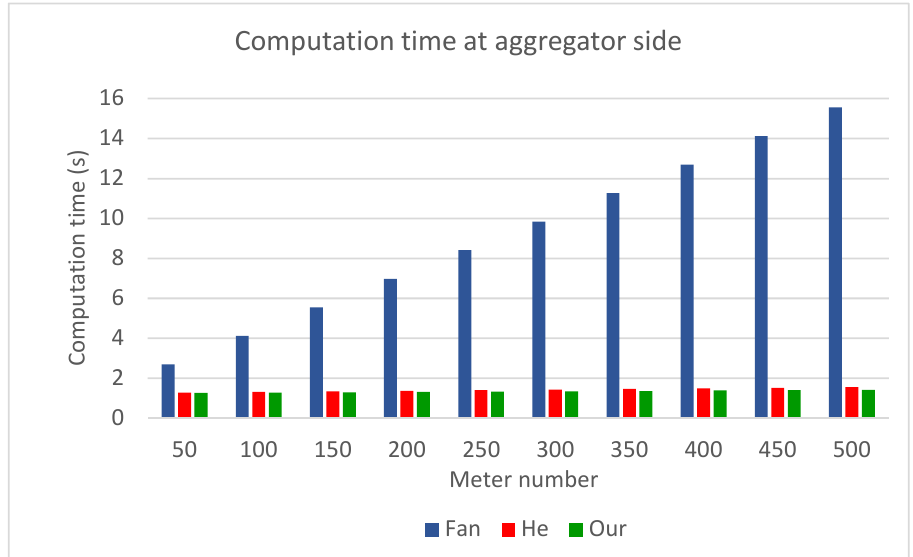
Figure 4. Computation costs at aggregator in aggregation phase.